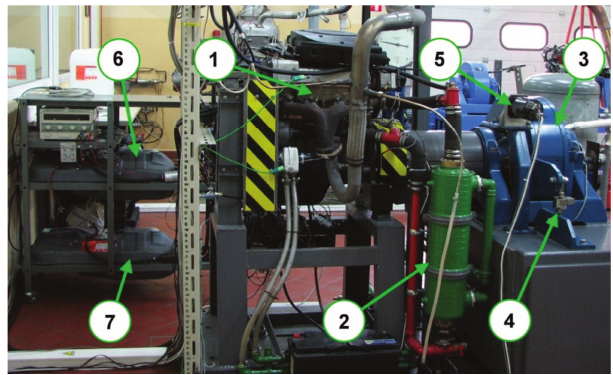
Fig. 2. Test stand – general view: 1 – research engine of Fiat 1100 MPI type, 2 - radiator, 3 – eddy-current engine brake made by Schenck, 4 – transducer of engine load, 5 – engine speed sensor, 6 – alcohol tank, 7 – gasoline tank